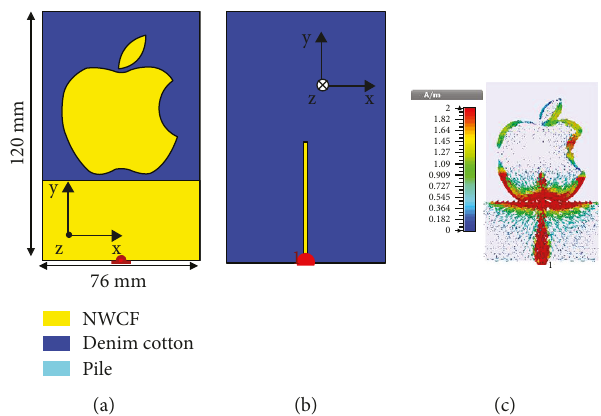
Figure 1: Original design: (a) front view; (b) back view; (c) surface current distribution at 2.5GHz.